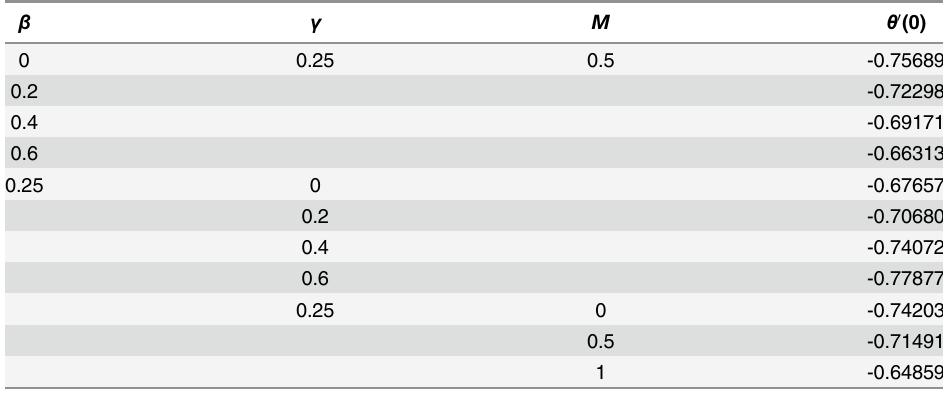
doi:10.1371/journal.pone.0153481.t002